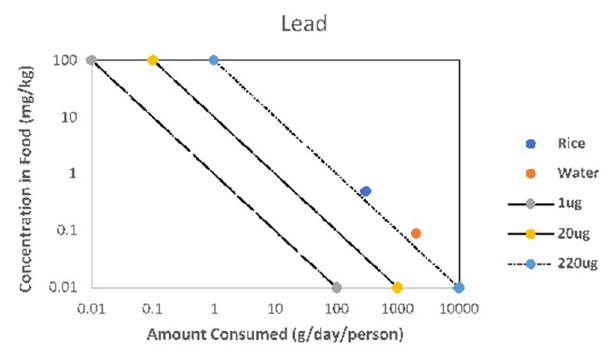
FIGURE 2 | Amount consumed: rice and water with Pb concentration of rice and well water in CKDu endemic